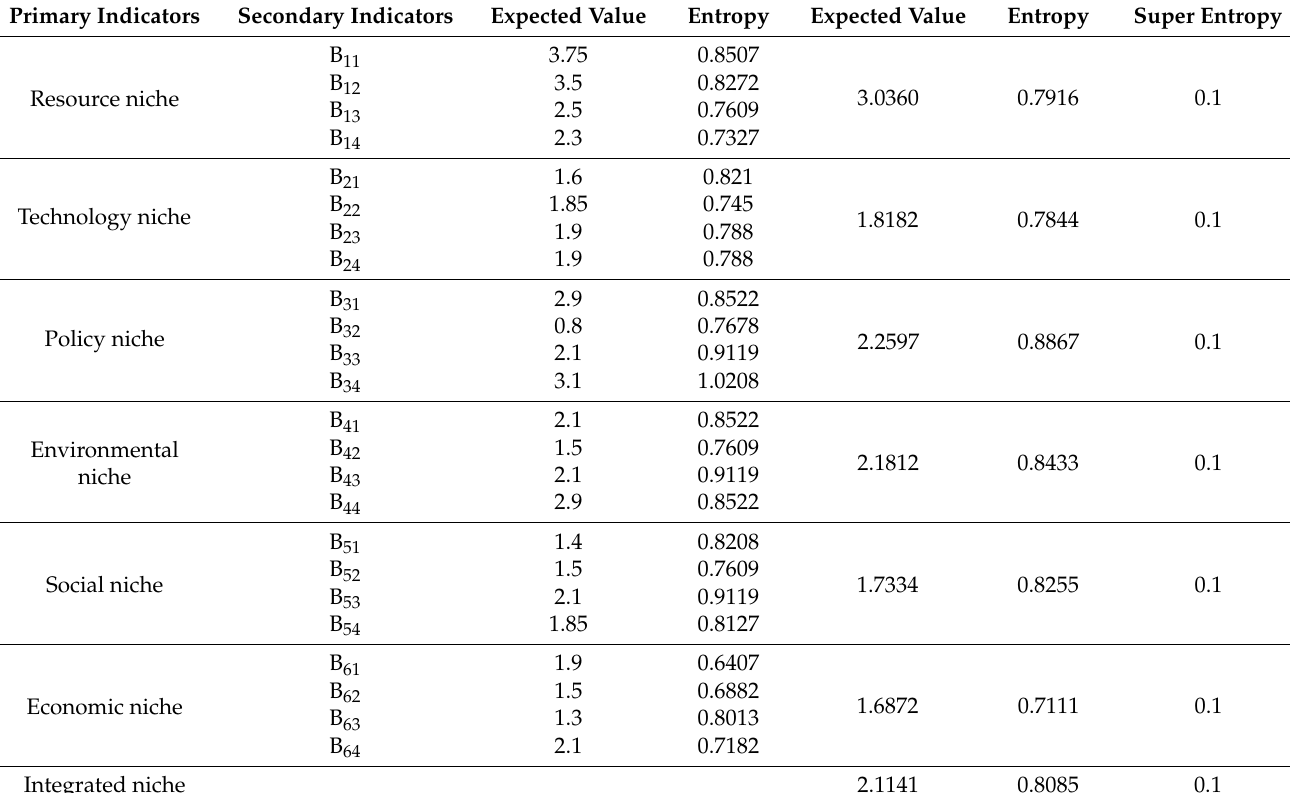
Figure 7. Cloud map of integrated niche. Table 7. Digital eigenvalues of each